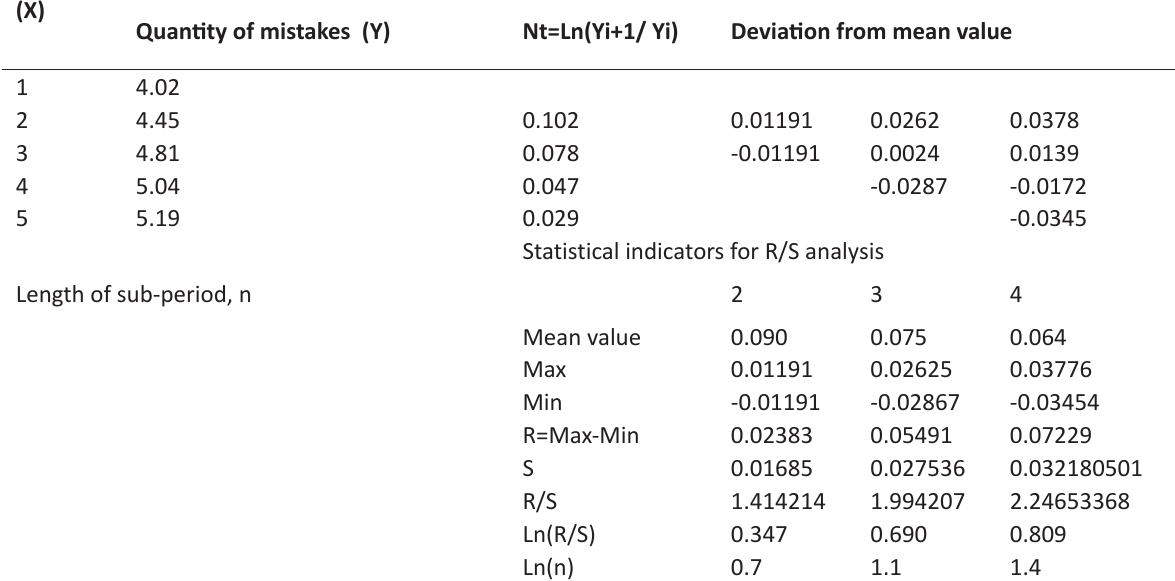
Table 2. Parameters for Hurst’s indicator determination ( experimental group ping pong in May) 2016 Parameters for Hurts’s indicator determination (experimental group ping pong in May) 2016 Set № (X)